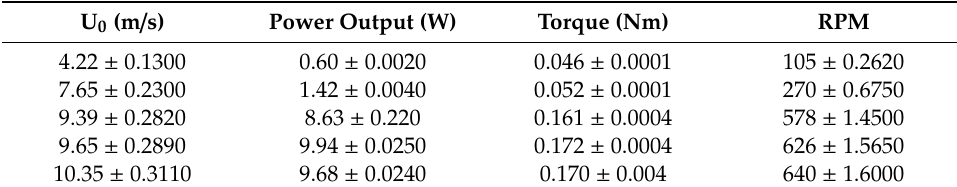
Table 1. Experimental Data.